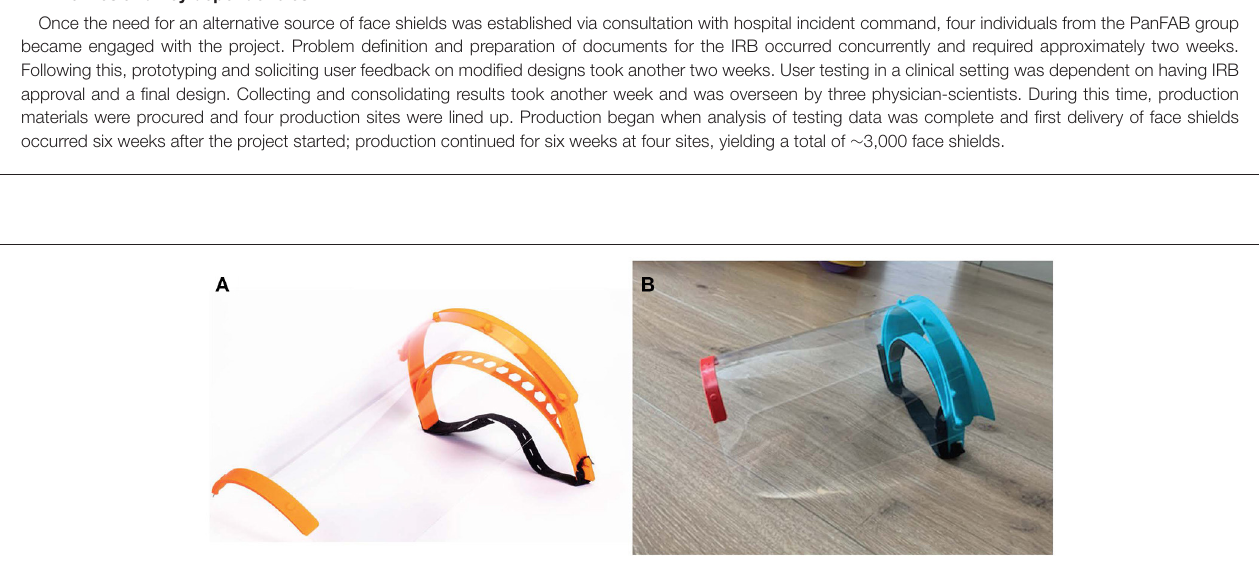
FIGURE 3 | Face shields fabricated during the COVID-19 pandemic. (A) Image of Prusa RC2 design and (B) final PanFab face shield prototype. See text for references and